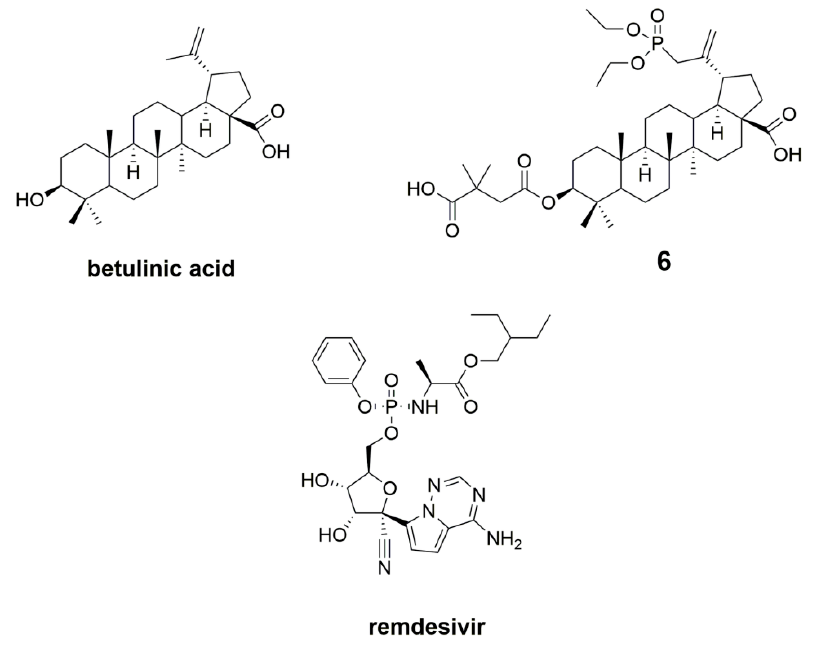
Figure 7. Additional ligands used for docking study for SARS-CoV-2.